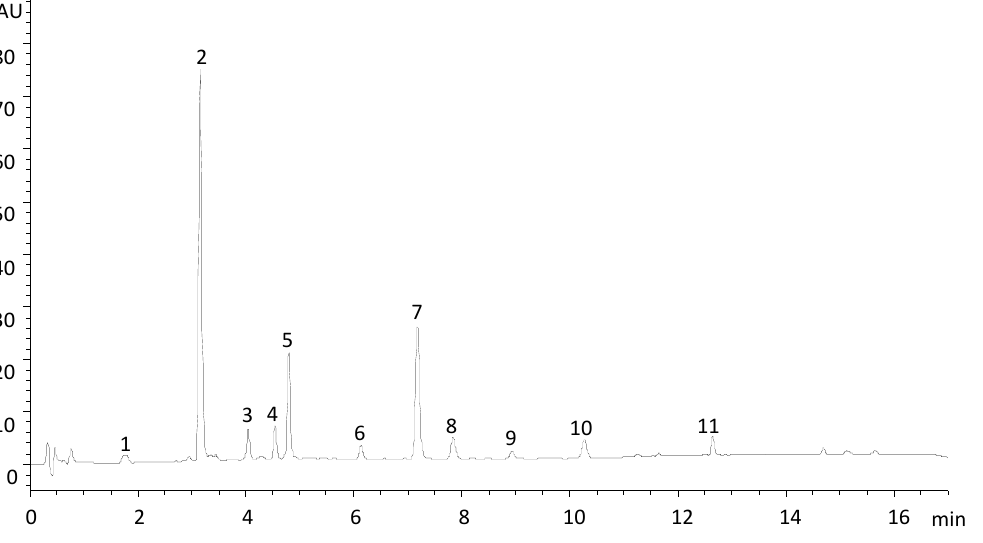
Figure 2. HPLC-DAD ( λ = 329 nm) chromatogram of carrot extract. Peaks identified as 3-CQA (1), 5-CQA (2), FRut (3), FQA (4), CDA (5), 3,5-diCQA (6), diCDA (7), 4,5-diCQA (8), CFDA (9), FDA (10), diFDA (11). Table 1. MS data of tentatively identified phenolic acids in